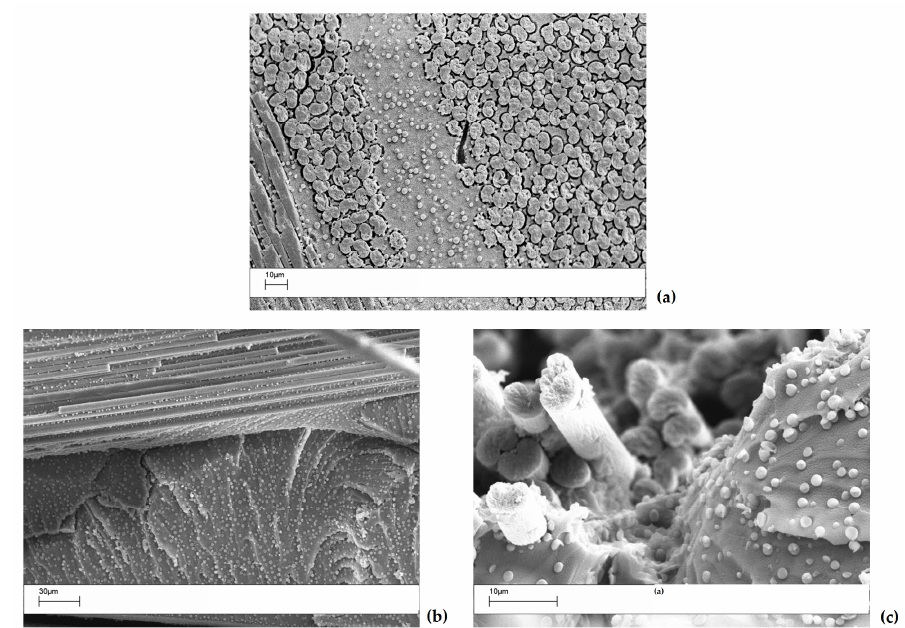
Polymers 2017 , 9 , 281 9 of 15 The interlaminar region of the sample with 10 wt % of coPES/1% POSS showed distinctive features with respect to that with a coPES veil (Figure 9). In this sample, a bimodal distribution of coPES rich particles appeared, with small 1–3 µm particles and bigger 5–7 µm particles (for Figure 8. SEM analyses of the interlaminar region for the composite with a 10 wt % coPES veil Figure 8. SEM analyses of the interlaminar region for the composite with a 10 wt % coPES veil dissolved magnification 500× and 4000×). In addition to that, regions with phase-inverted morphology and dissolved in it: ( a ) polished section of the laminates; ( b , c ) crio-fractured surfaces for the same laminate. in it: ( a ) polished section of the laminates; ( b , c ) crio-fractured surfaces for the same laminate. squared micro POSS agglomerates appeared.